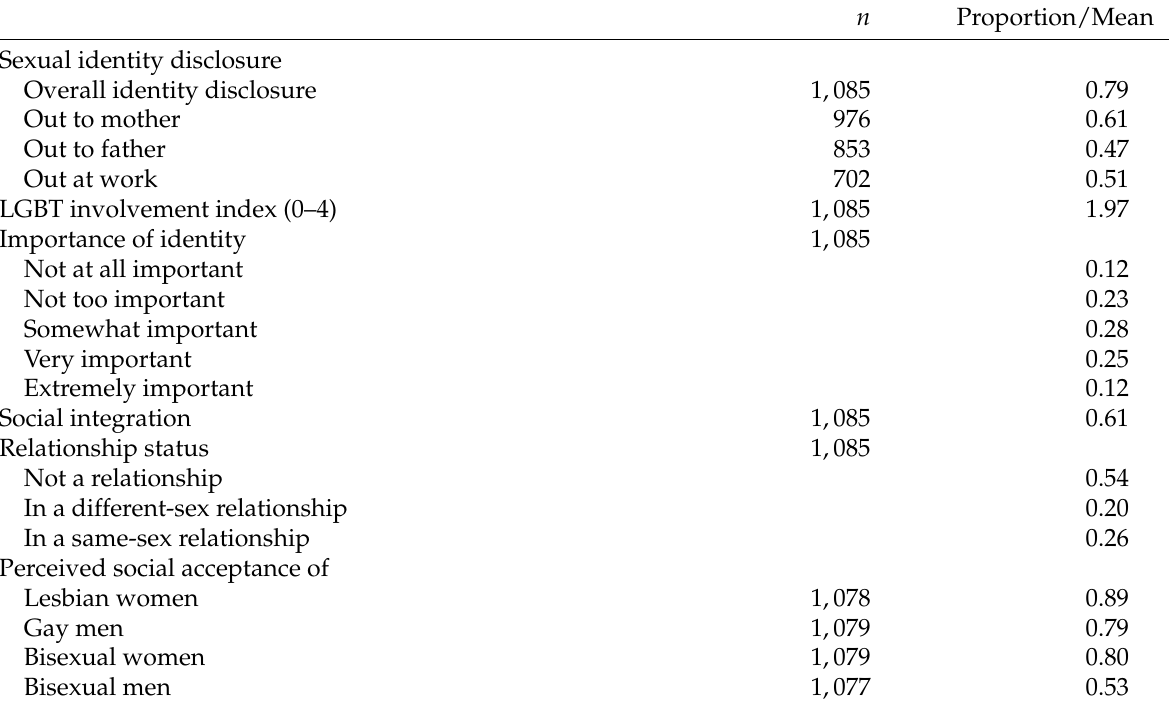
Table 2: Description of key